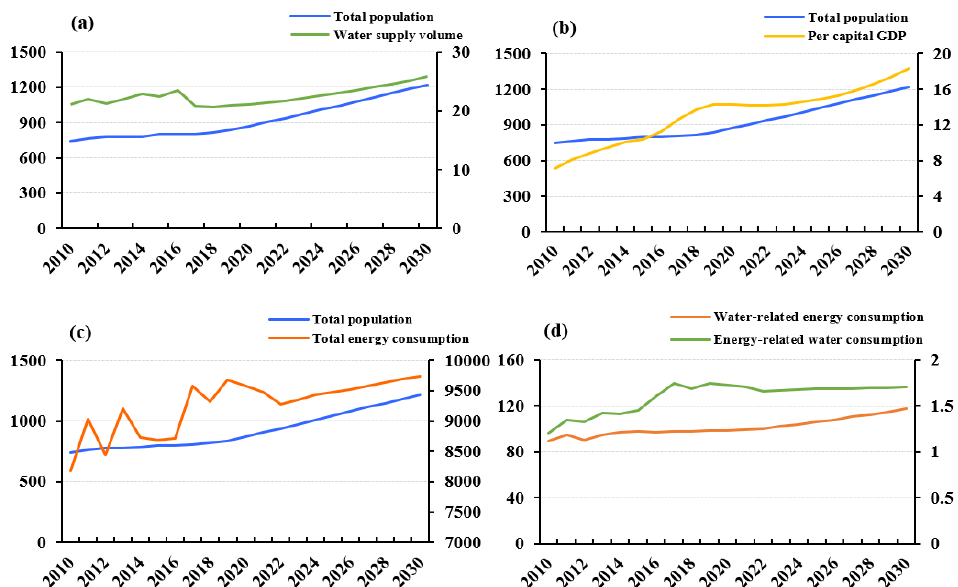
Figure 5. ( a ) Trend analysis chart of the total population (10,000 people) and water consumption (100 million m 3 ). ( b ) Trend analysis chart of the total population (10,000 people) and per capita GDP (10,000 yuan). ( c ) Trend analysis chart of the total population (10,000 people) and total energy con- sumption (10,000 tce). ( d ) Trend analysis chart of the water-related energy consumption (10,000 tce) and energy-related water consumption (100 million m 3